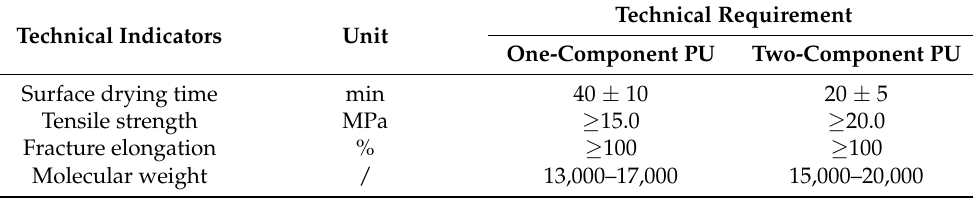
Table 2. Technical indexes of PU binder.